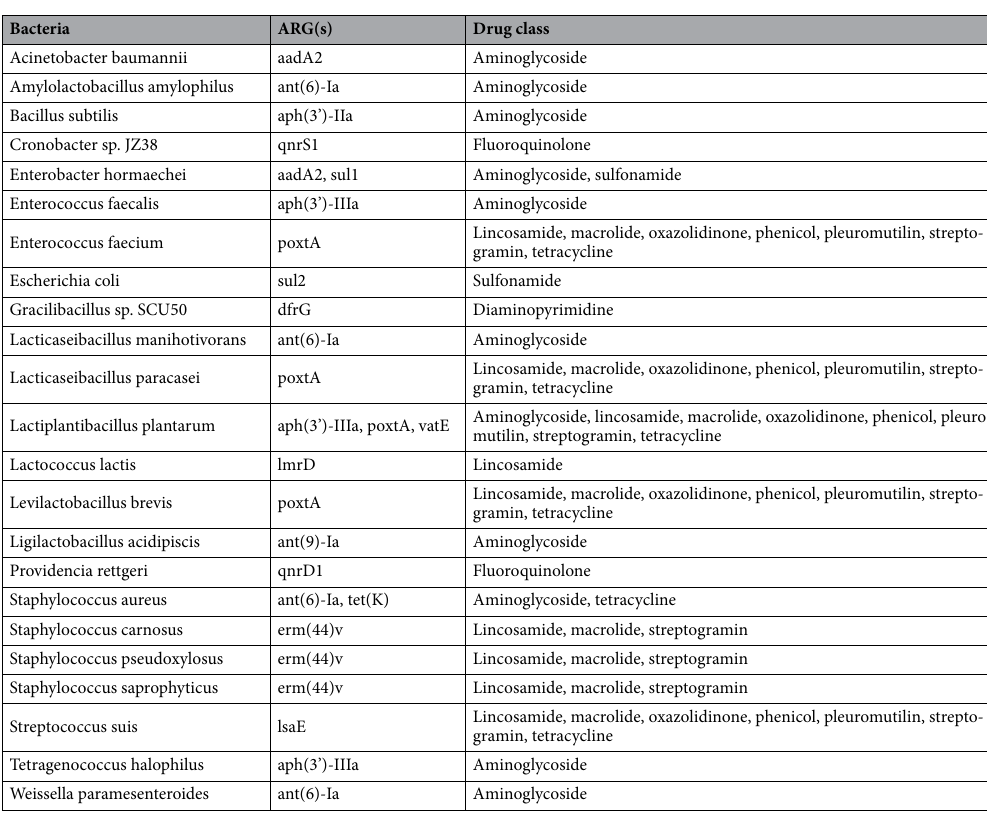
Table 1. Identified ARGs and the drug classes affected by them per bacterial species of